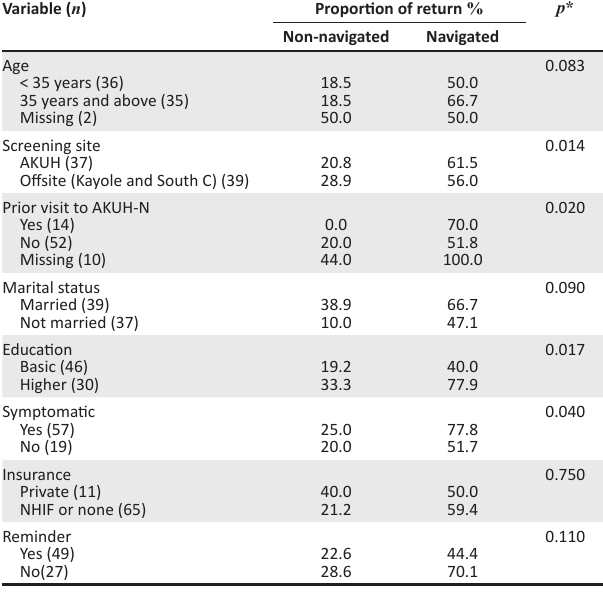
TABLE 5: Effect of different variables on